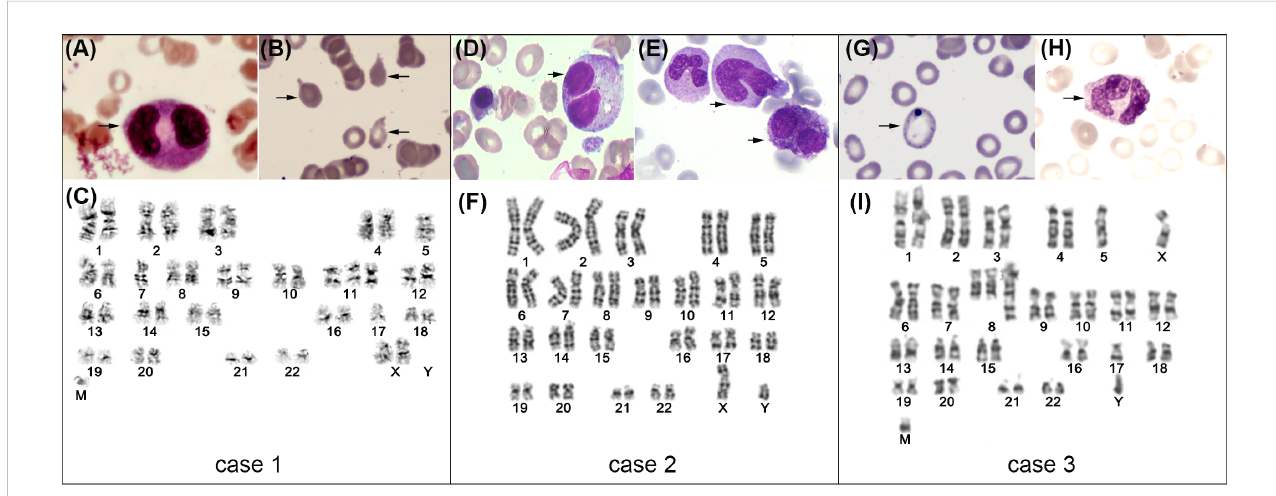
FIGURE 1 BMA of case 1~3 at diagnosis of MDS (representative images of BM cytomorphology and karyotype analysis). For case 1 (A – C) : binuclear myelocyte (A) , teardrops (B) and karyotype analysis depicting 45, XX, -5, -7, +add (11) (p15), -17, +mar (C) . For case 2 (D~F): binuclear myelocyte (D) , giant neutrophils and hyposegmented neutrophils (E) , and karyotype analysis depicting 46, XY (F) . For case 3 (G – I) : basophilic stippling of red cells (G) , binuclear myelocyte (H) , and karyotype analysis depicting 42~46, XY, del (3) (p24), -5, +add (8) (q24.1), -17, add (18) (q23), +mar, inc[cp9]/46, XY